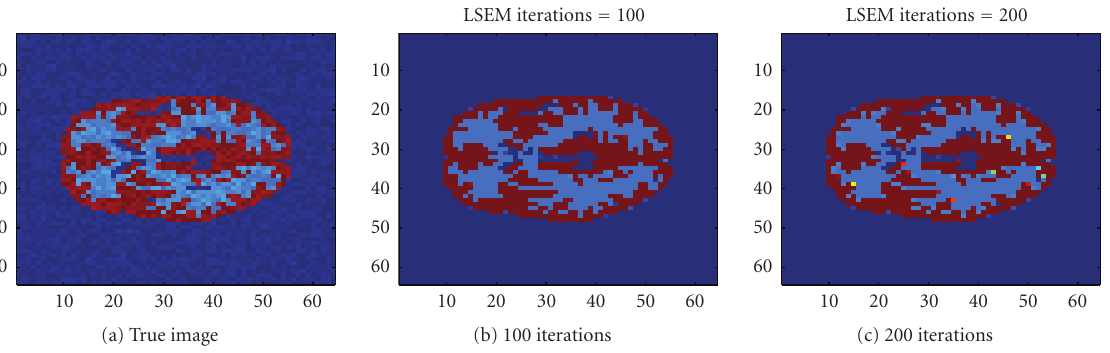
Figure 18: 64 × 64 segmented MRI slice of the brain, nonpiecewise constant by adding Rand()